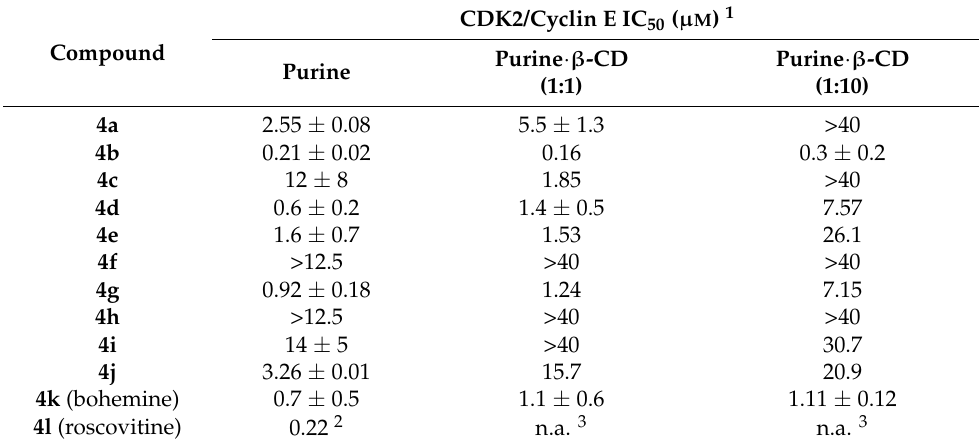
Table 1. CDK inhibition activity of purines 4a – l and their complexes with β